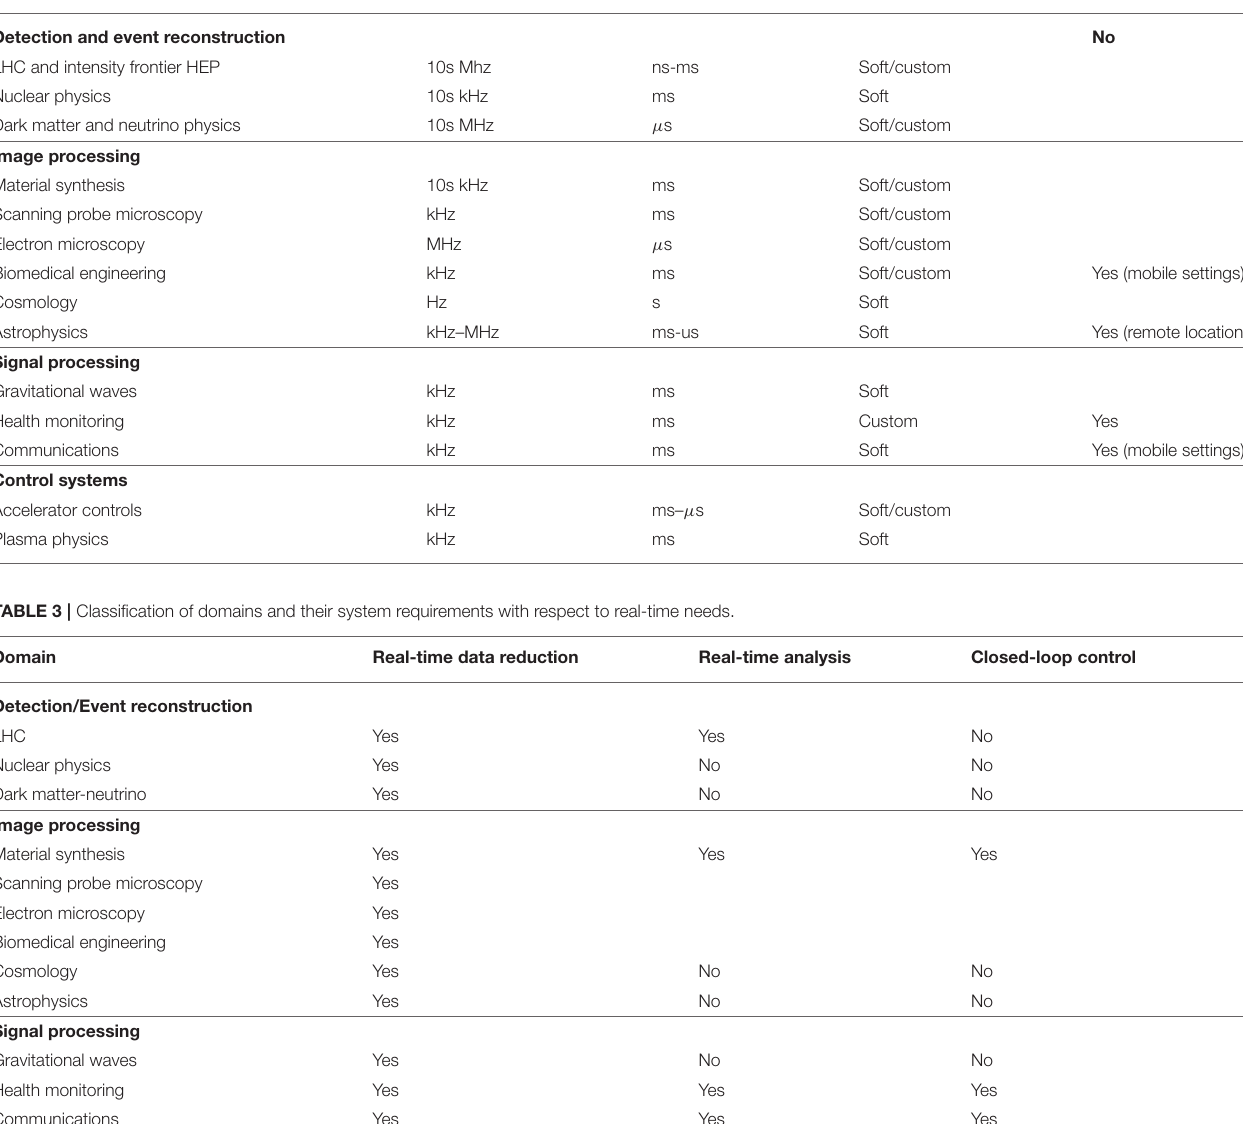
TABLE 2 | Domains and practical constraints: systems are broadly classified as soft (software-programmable computing devices: CPUs, GPUs, and TPUs) and custom (custom embedded computing devices: FPGAs and ASICs). Domain